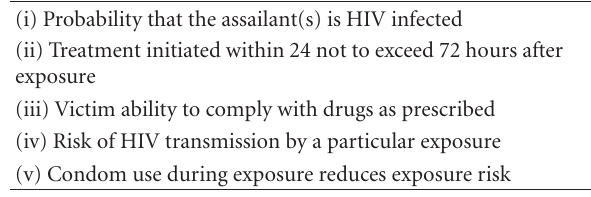
Table 1: Key elements to consider prior to HIV postexposure prophylaxis.